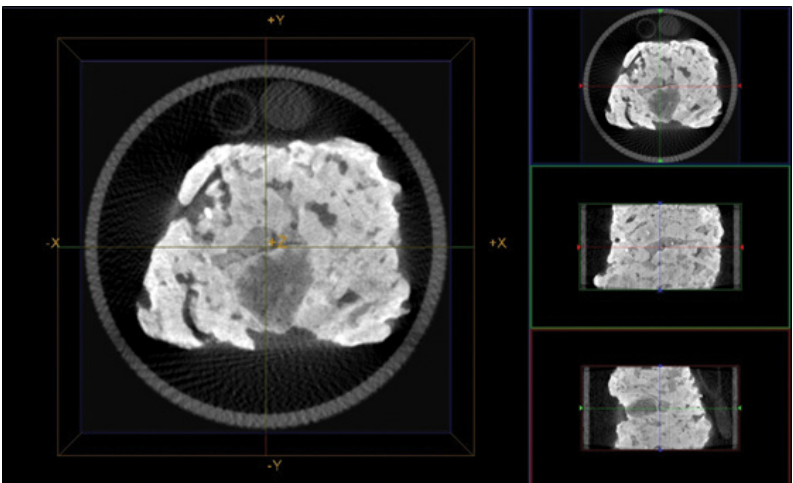
Figure 3. Cross-section of an ironstone fragment (47 × 38 mm, in the XY axis) showing “vermicular” porosity, large irregular partially infilled pores, and dense masses (bright areas) on the outer rims or isolated grains. The large image shows the combination of the X, Y, and Z (Z orthogonal to XY) axes. The smaller images show, from top to bottom, the XY, XZ, and ZY